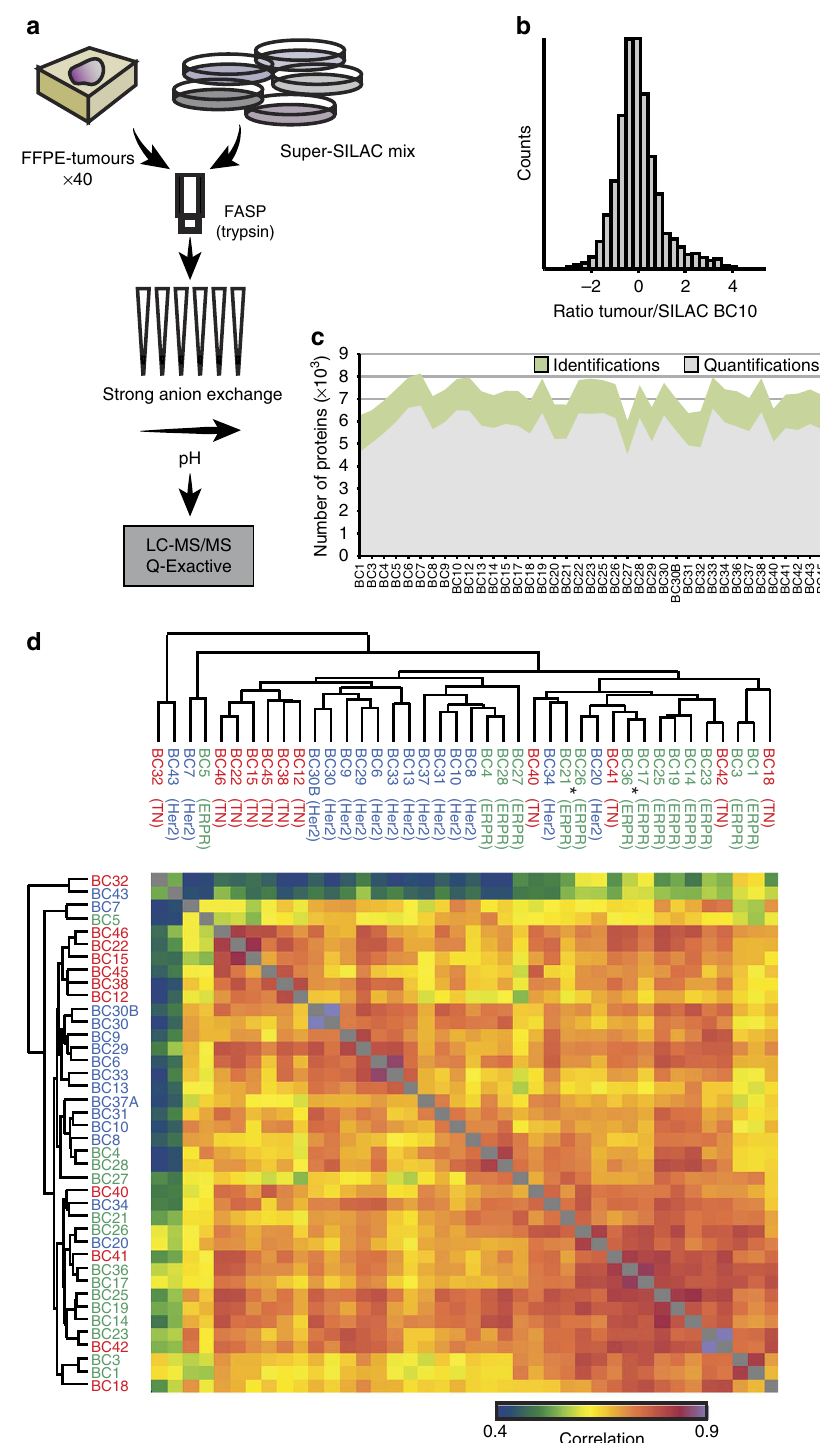
0.4 Figure 1 | Super-SILAC-based quantitative proteomics of breast cancer clinical samples. ( a ) Proteomics workflow involved combination of the super- SILAC mix with FFPE tumour samples, followed by FASP digestion with trypsin, peptide fractionation and analysis on the Q Exactive MS. ( b ) Ratio distribution between the tumour proteome (of one representative tumour) and the super-SILAC mix showed overall narrow distribution that enables accurate ratio determination. ( c ) Plot shows the number of identified and quantified proteins in each tumour sample. ( d ) Hierarchical clustering of Pearson correlations of breast cancer samples shows high diversity between tumour samples, with only partial co-clustering of samples of the same classical subtype. Two triple-positive tumours are marked with *. the subtypes and performed annotation matrix analysis in differences between breast cancer subtypes using the molecular Perseus, a statistical module in the MaxQuant software signatures database (MSigDB) resource of gene sets 18 . For each protein, we calculated the mean difference of expression between (http://www.perseus-framework.org/). Using the non-parametric NATURE COMMUNICATIONS|7:10259|DOI: